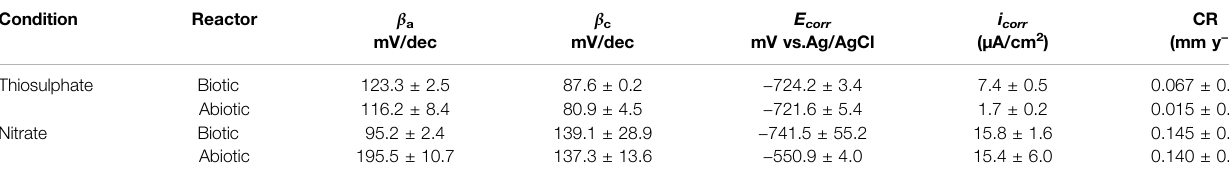
TABLE 2 | Electrochemical parameters obtained from Tafel analysis.